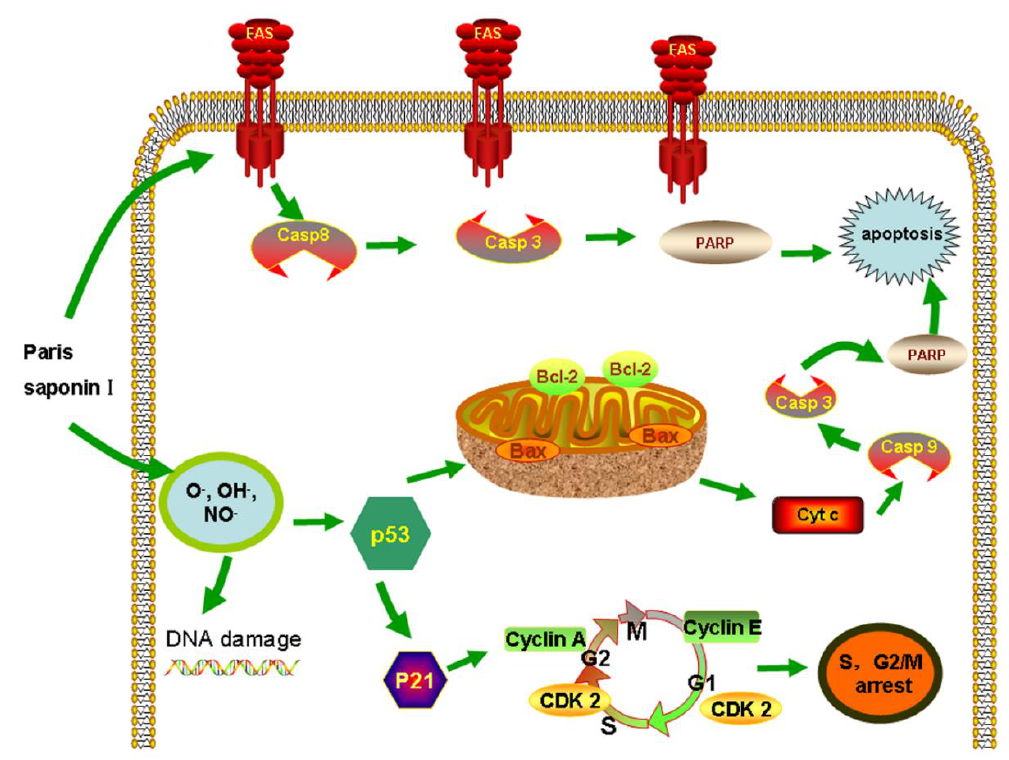
Figure 10. The extrinsic and intrinsic pathway of apoptosis induced by PSI.